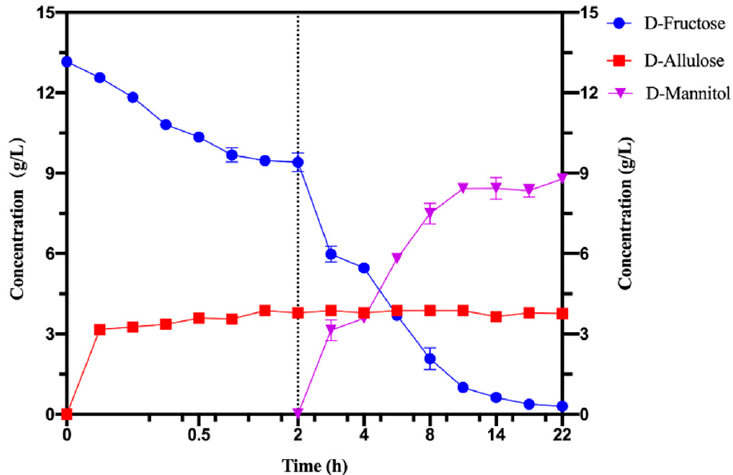
Figure 5. Bioconversion of pear peel into D-allulose and D-mannitol catalyzed by purified Dosp- KEase and MDH-FDH whole-cell with two-stage strategy.